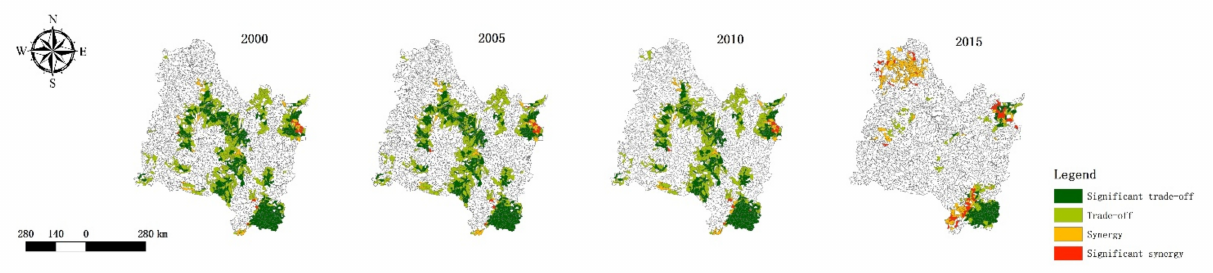
Figure 16. The synergy/trade-off relationship between water retention and crop production. The synergy/trade-off relationship between crop production and soil conservation